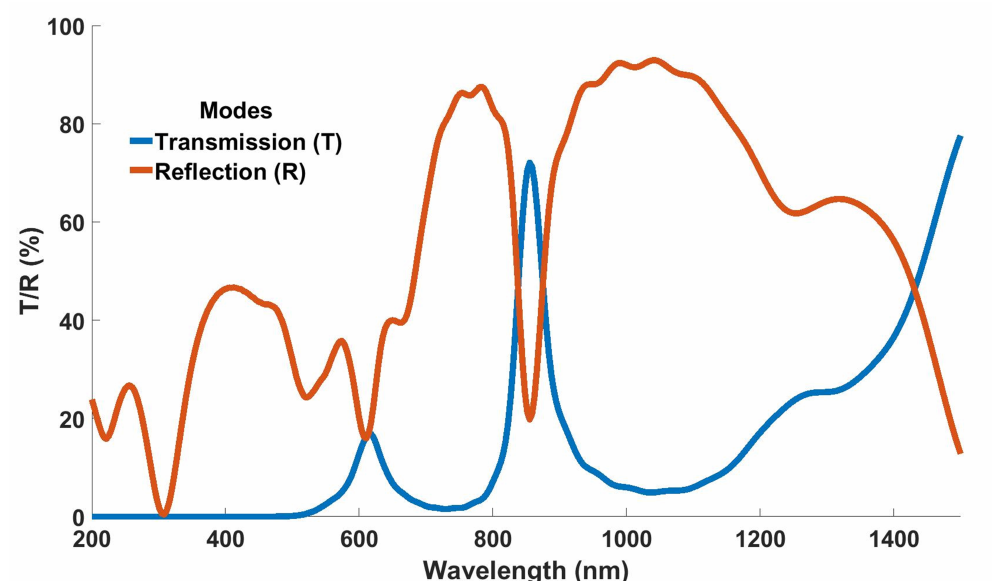
Figure 12. Response of cascaded multilayered thin-film filter in transmission and reflection